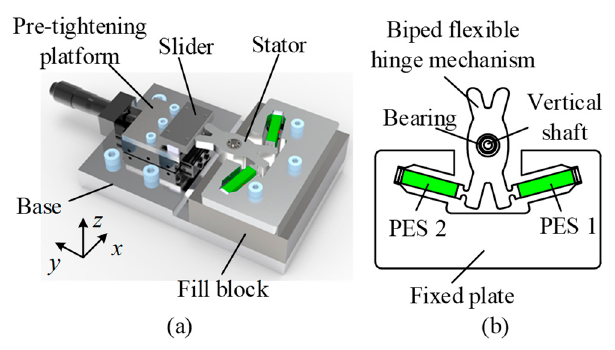
Figure 1. ( a ) Model of the proposed actuator, and ( b ) structure of the